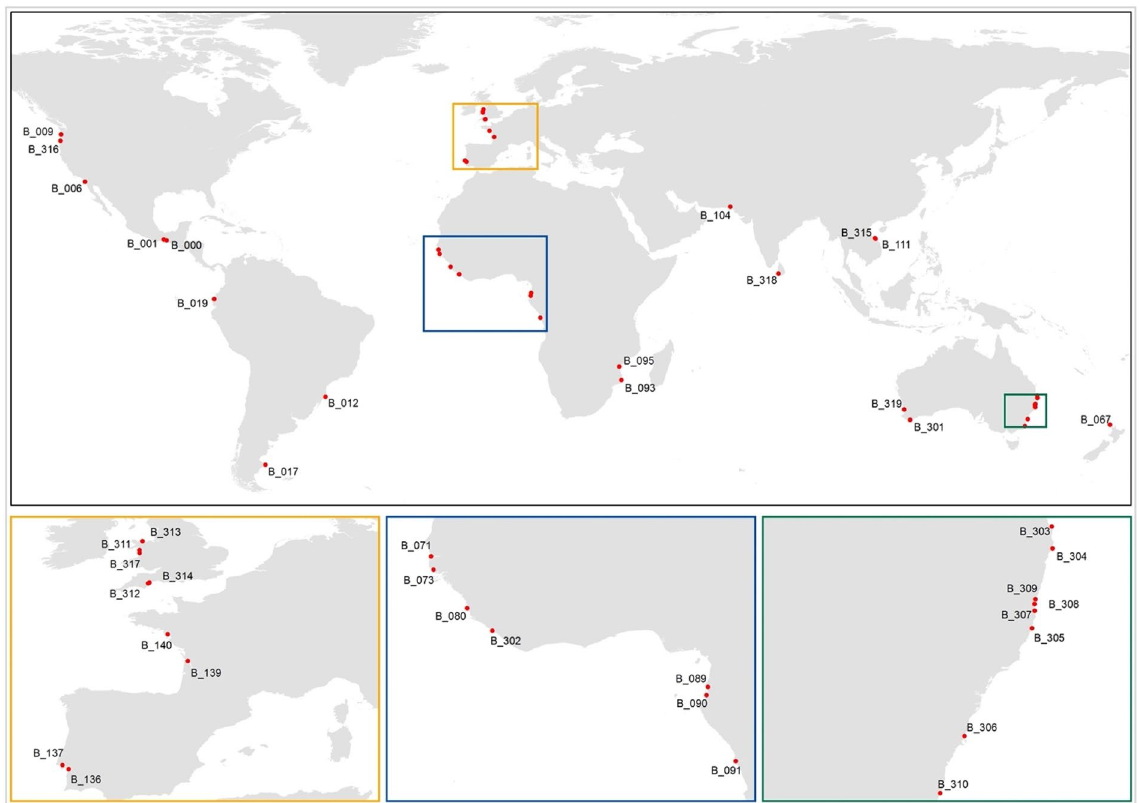
Figure 1. Locations of the selected catchment-estuary-coastal systems. Original data sources comprise: systems B_303 to B_310 are from the New South Wales (Australia) estuary dataset 33 ; systems B_311 to B_314 are from the UK estuary dataset 32 ; systems B_301, B_319 and B_315 are from the SMIC model application 18 ; system B_302 is from the published literature 34,35 ; systems B_316 to B_318 are from the original G-SMIC application 22